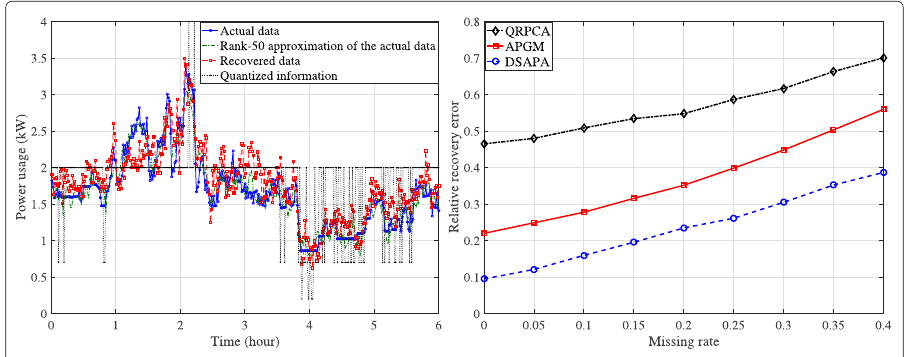
Fig. 12 a Comparison of actual data, rank-50 approximation, recovered data, and quantized data (USMD). b Relative recovery error when the missing rate